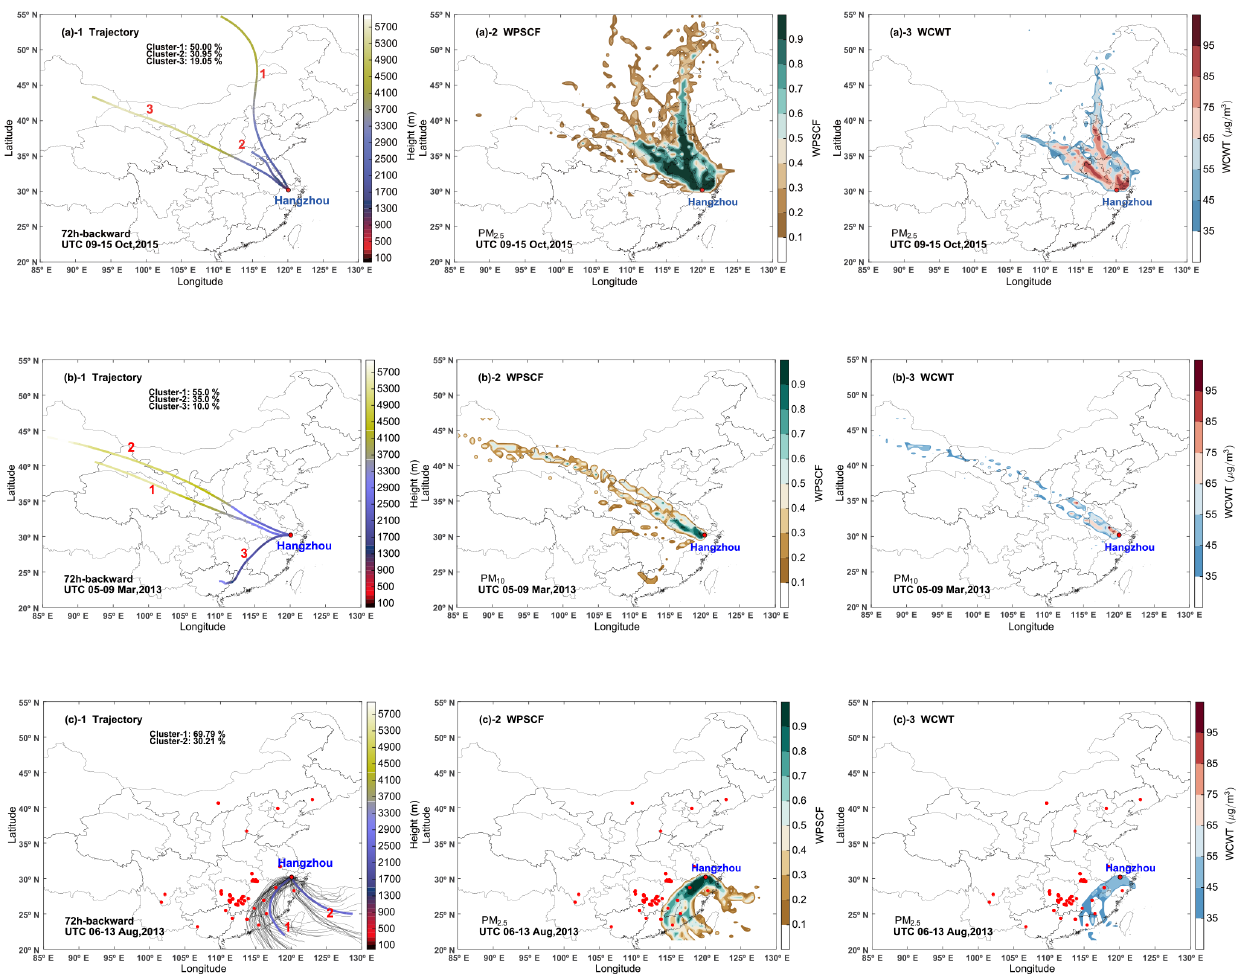
Figure 7. Mean 72h backward trajectories of each trajectory cluster and spatial distributions of WPSCF and WCWT values for PM 2 . 5 in Hangzhou during (a) 9–15 October 2015, (b) 5–9 March 2013, and (c) 6–13 August